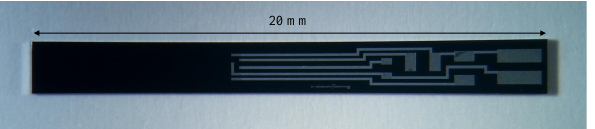
Figure 3. Photo of the silicon chip carrier.